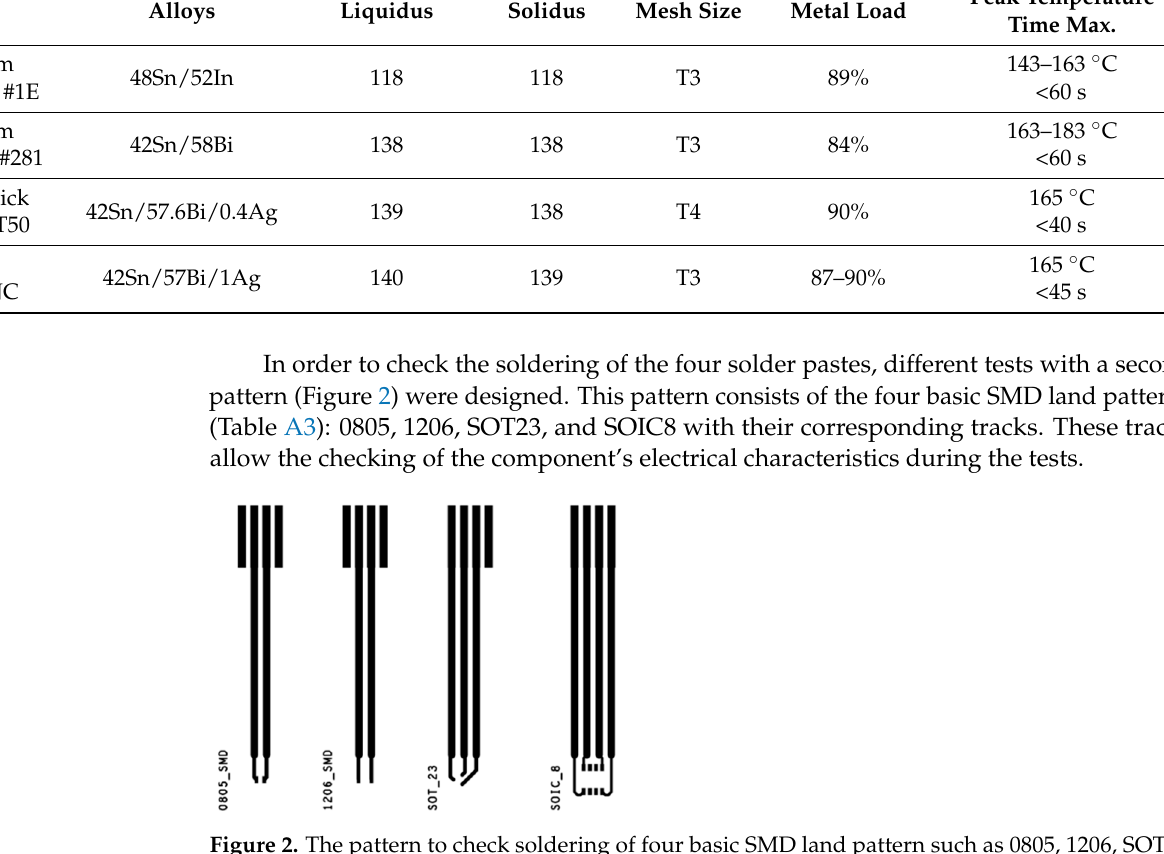
Figure 2. The pattern to check soldering of four basic SMD land pattern such as 0805, 1206, SOT23, and